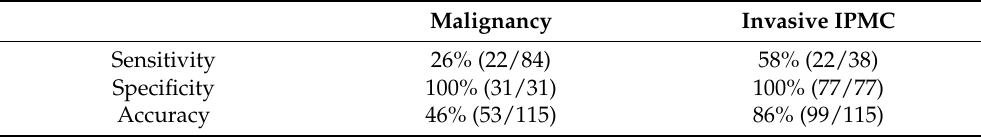
Figure 5. Receiver operating characteristics curve of the presence of mural lesions on contrast-enhanced CT for the diagnosis of invasive IPMC. CT, computed tomography; IPMC, intraductal papillary mucinous neoplasm-associated invasive carcinoma. An early wash-out pattern on CH-EUS was observed in 22 of 38 (58%) cases of invasive IPMC, but not in LGD/IGD (0/31) or HGD (0/46). An early wash-out pattern was observed in significantly more patients with invasive IPMC than in those with HGD or LGD/IGD ( p < 0.001; Table 6). An early wash-out pattern was also observed in significantly more patients with malignant IPMN (including HGD and invasive IPMC) than in those with LGD/IGD ( p < 0.001; Table 6). Table 6. Diagnostic Abilities for Malignancy and Invasive IPMC According to an Early Wash-out Pattern on